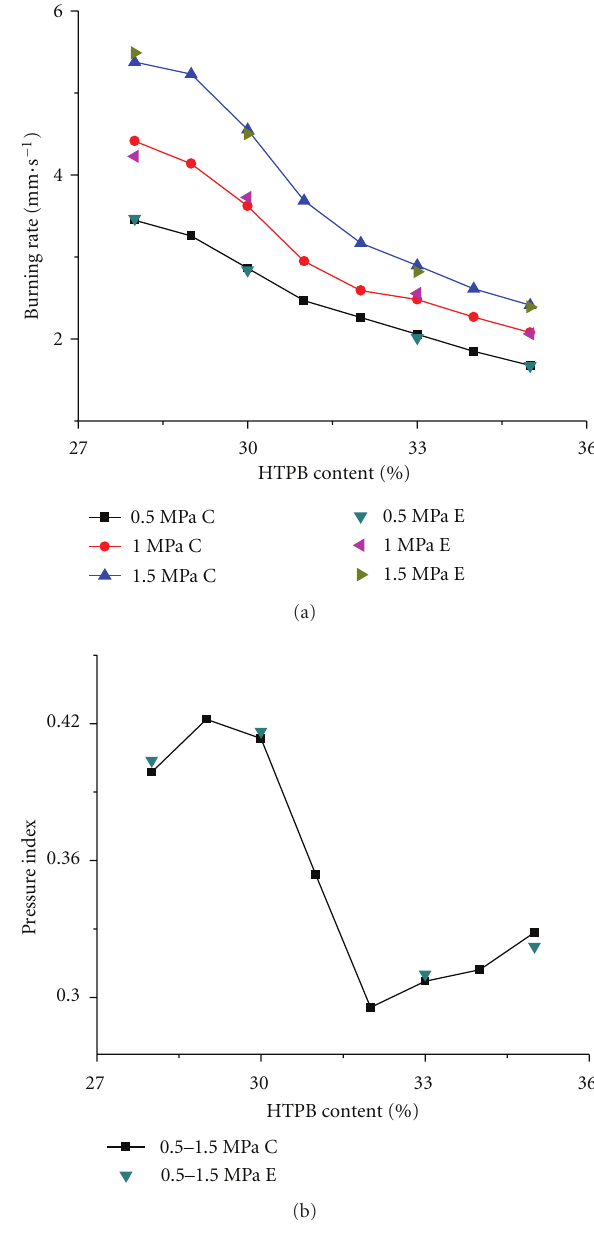
Figure 2: E ff ect of HTPB content (wt%) on burning rate (a) and pressure index